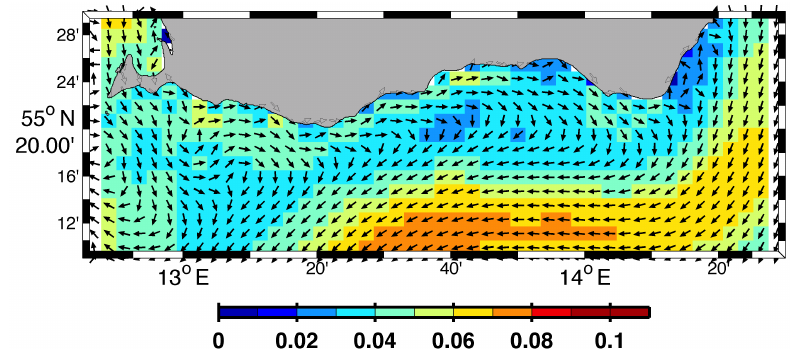
Figure 6. Surface circulation off the southernmost coast of Sweden in summer (climatological July calculated from model output comprising the years 1989 to 1993). The arrows show the direction of the currents. The colour denotes the speed in units ms − 1 .